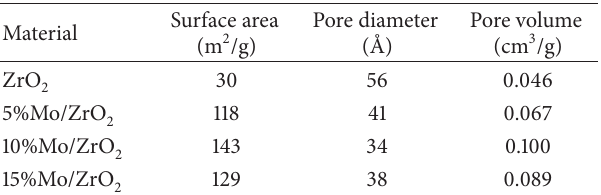
Figure 6: XRD patterns of ZrO 2 and MoO 𝑥𝑦− /ZrO 2 , ( ◼ ) tetragonal ZrO 2 , ( ◻ ) monoclinic ZrO 2 , and ( e ) orthorhombic MoO 3 . Table1:Specificsurfaceareaandporousstructureparametersofthe synthesized materials.